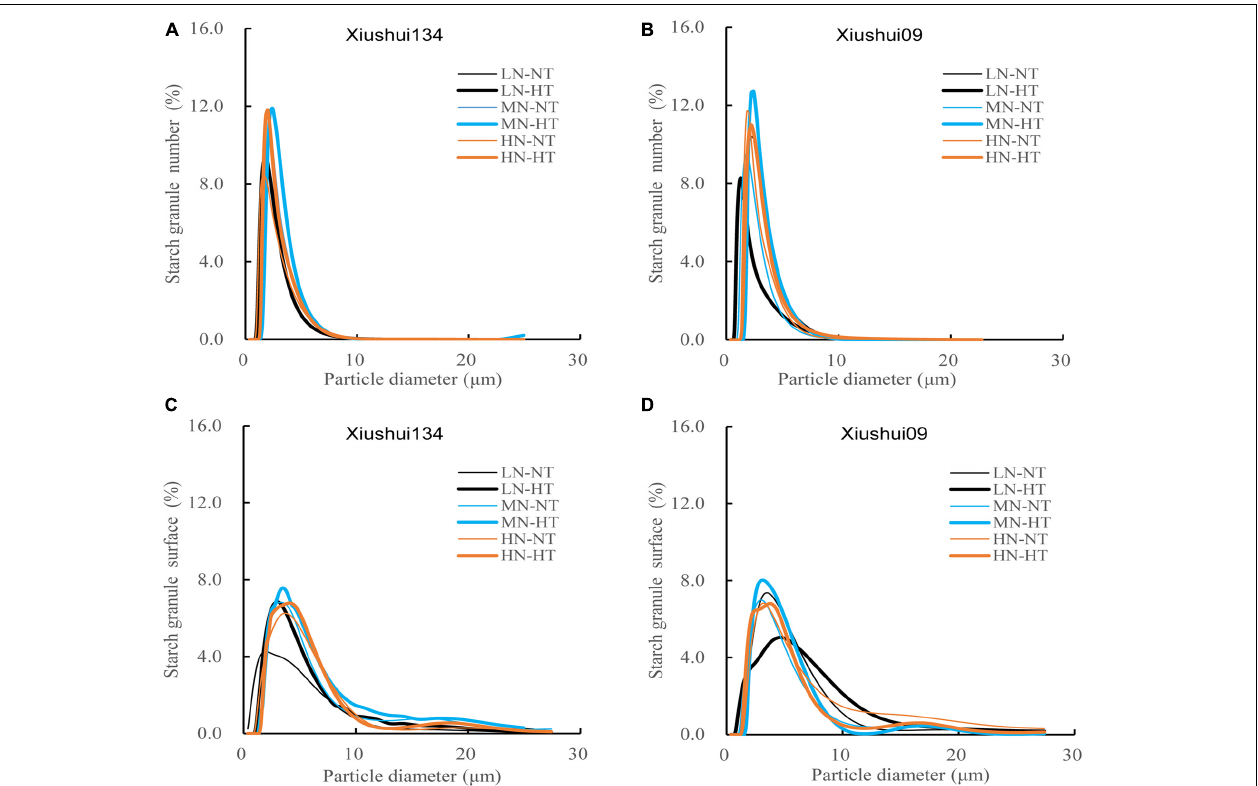
FIGURE 2 | Comparison of starch particle distribution (number- and surface area based proportion) for different nitrogen-temperature treatments. LN-NT, MN-NT, HN-NT, LN-HT, MN-NT, and HN-HT indicate low nitrogen-normal temperature, moderate nitrogen-normal temperature, high nitrogen-normal temperature, low nitrogen-high temperature, moderate nitrogen-high temperature, and high nitrogen-high temperature, respectively. (A) Starch particle distribution of percentage number in Xiushui134, (B) Starch particle distribution of percentage number in Xiushui09, (C) Starch particle distribution of percentage surface in Xiushui134, (D) Starch particle distribution of percentage surface in